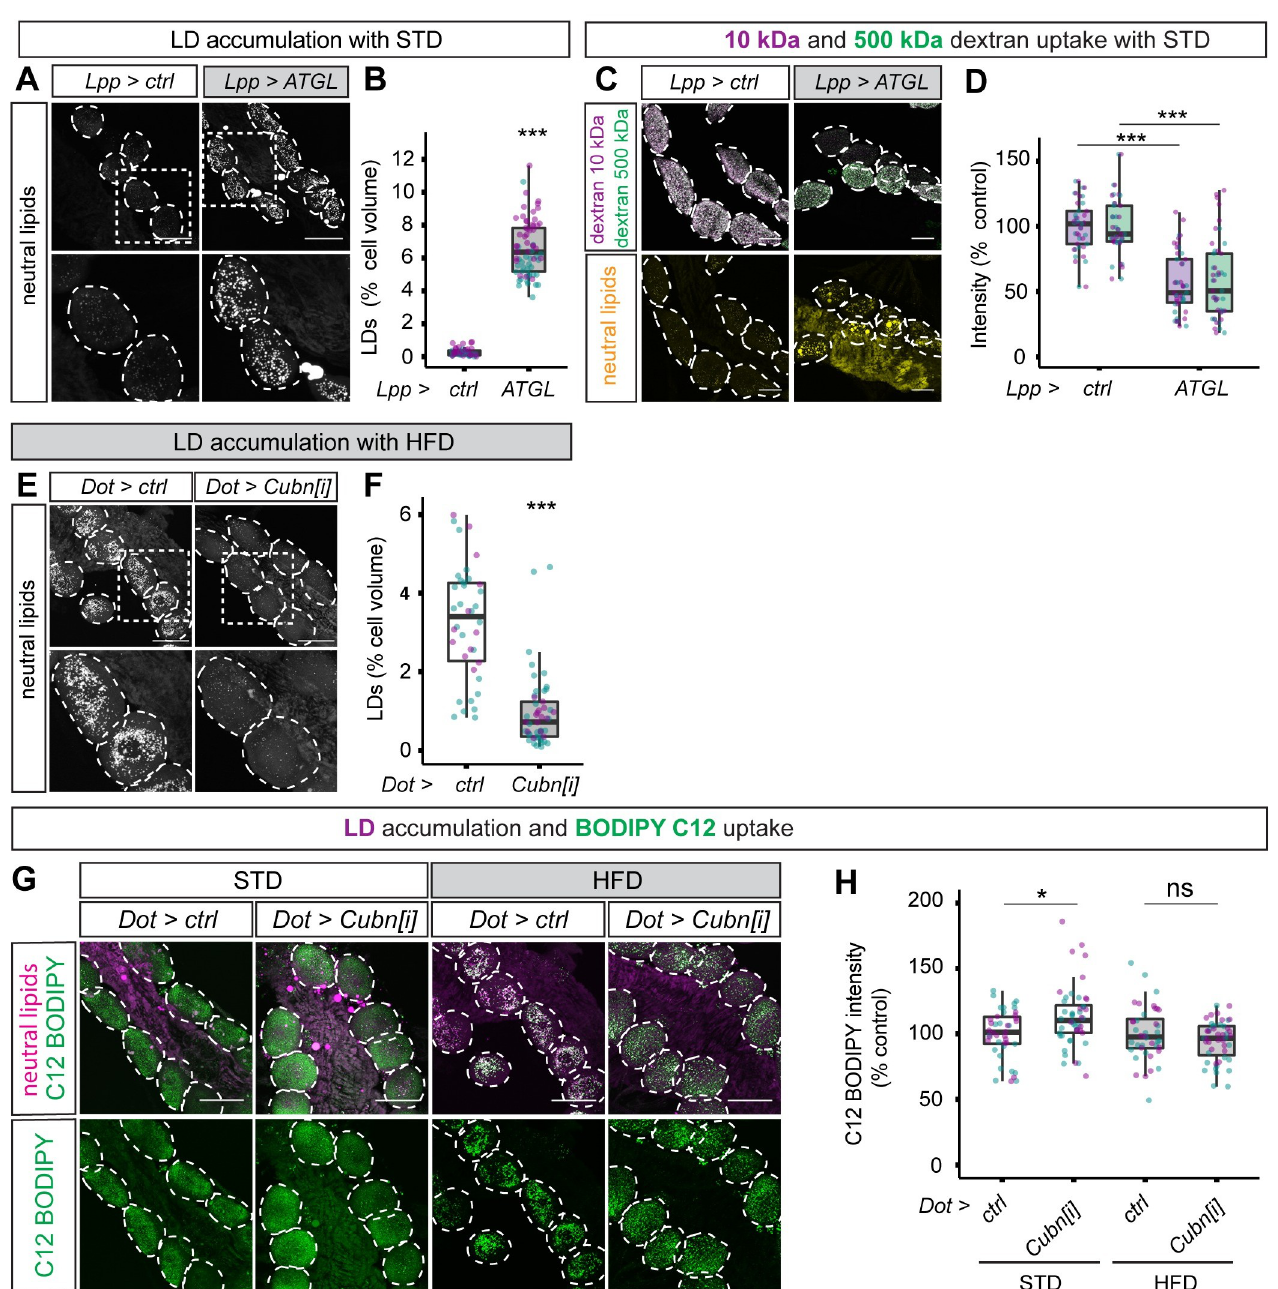
Fig 4. Fat body lipolysis induces and Cubn-dependent endocytosis blocks renal lipid droplets. ( A , B ) Confocal panels (A) and quantifications (B) show that lipid droplets (marked with LipidTOX) accumulate in nephrocytes (dashed outlines in A) of STD larvae expressing ATGL in the fat body ( Lpp > ATGL ) but not in controls ( Lpp > ctrl ). ( C , D ) Confocal micrographs (C) and quantifications of dextran mean fluorescence intensity (D) show that ex vivo dextran uptake is decreased in nephrocytes of larvae expressing ATGL in the fat body ( Lpp > ATGL ) but not in those of control larvae ( Lpp > ctrl ). Similar results are obtained with 10-kDa and 500-kDa dextrans. ( E , F ) Confocal micrographs (E) and quantifications (F) show that lipid droplets (marked with LipidTOX) are far less abundant in the nephrocytes (dashed outlines in E) of nephrocyte-specific Cubn knockdown ( Dot > Cubn[i] ) compared to control ( Dot > ctrl ) HFD larvae. ( G , H ) Confocal micrographs (G) and quantifications of fluorescence intensity (H) show that Cubn knockdown in nephrocytes ( Dot > Cubn[i] ) does not decrease ex vivo uptake of a fluorescent analogue of a C18 saturated free fatty acid (BODIPY FL C12) by nephrocytes from STD or HFD larvae. Panel G shows BODIPY FL C12 (green) and LipidTOX (magenta). See S1 Data for details of p -values and the type of statistical model used for all graphs in this study. S2 Data provides the source data used for all graphs and statistical analyses. ATGL, adipose triglyceride lipase; Cubn, Cubilin; HFD, high-fat diet; LD, lipid droplet; STD, standard